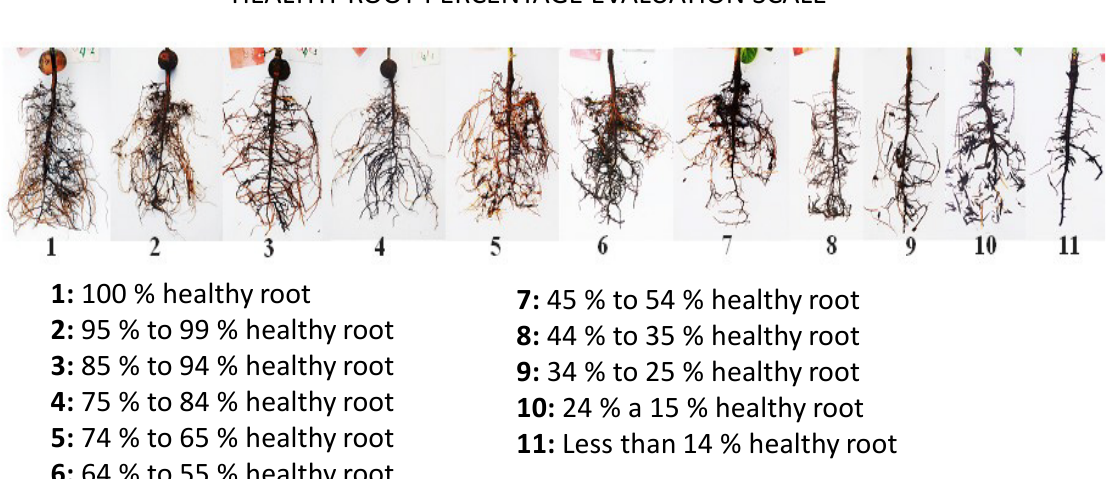
Fig. 1. Pictographic scale used to evaluate the percentage of healthy avocado roots inoculated with Phytophthora